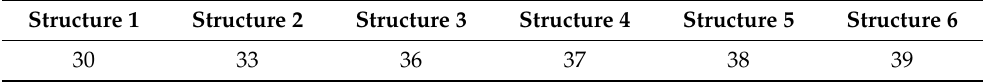
Table 1. Number of soft segments in one chain. Every chain consists of 40 segments.